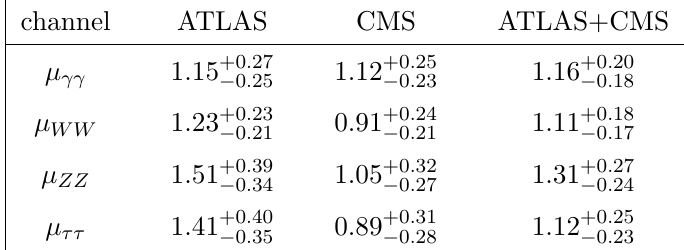
Table 2 . Combined ATLAS and CMS results for the 8 TeV data, ref.